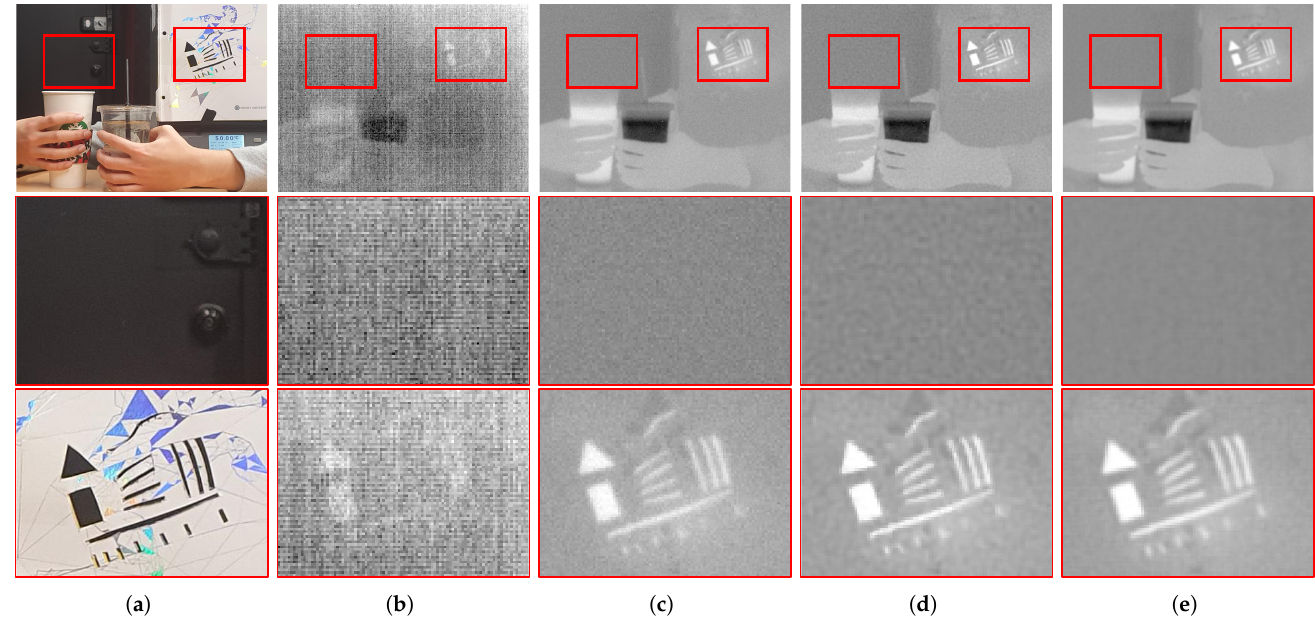
Figure 1. Comparative restored thermal images of an infrared camera. Thermal images commonly demonstrate quite worse qualities compared to visible-band images, so they require additional restoration processes. The conventional thermal image restoration framework consists of the FPN removal and deblur processes. The proposed framework jointly considers both problems in the deconvolution process. ( a ) Acquired visible-band image; ( b ) acquired thermal image; ( c ) FPN- removed image [14]; ( d ) deblurred image [11] after FPN removal process [14]; ( e ) restored image of the proposed